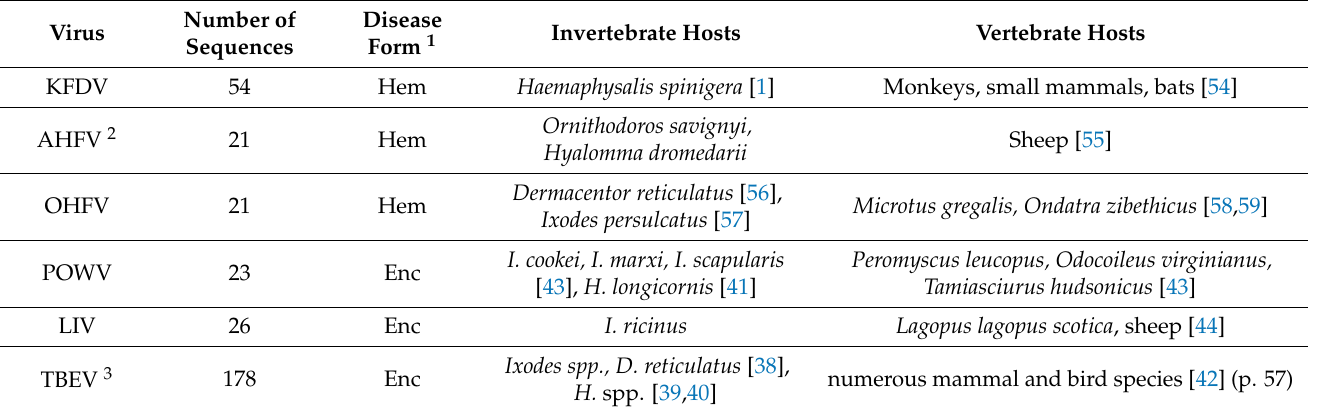
Table 3. Summary of sequences used in the